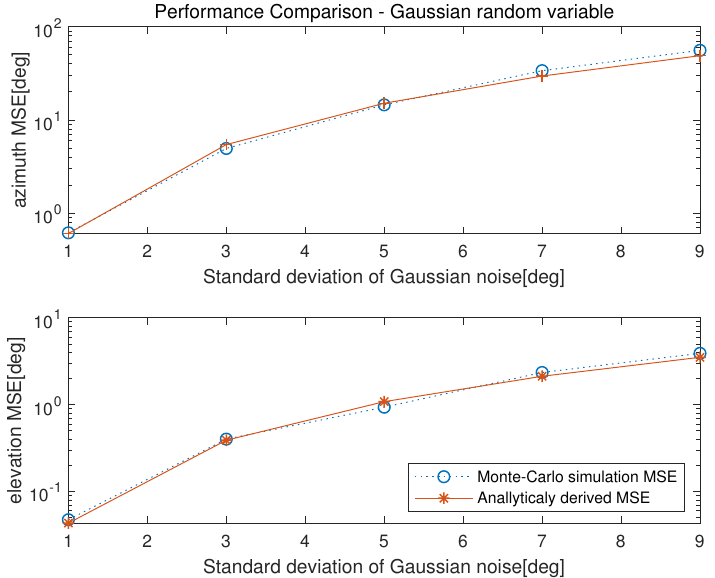
Figure 4. Performance for Gaussian − distributed phase measurement error with θ ( 0 ) = 120 ◦ and ψ ( 0 ) = 75 ◦ . This figure shows the MSEs of azimuth and elevation with respect to phase error at a signal with high incident elevation. It can be confirmed that the MSE of elevation is smaller than that of the azimuth at high elevation(uniform circular array).